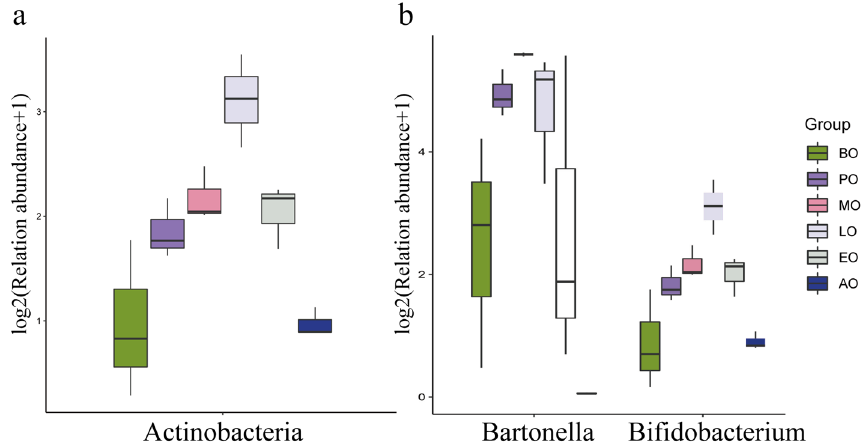
Figure 3. The significant differences in the bacteria in honeybees at the phylum and genus levels. ( a ) Box plot of significant differences in bacteria (Actinobacteria) at the phylum level. ( b ) Box plot of significant differences in bacteria (Bartonella and Bifidobacterium) at the genus levels.